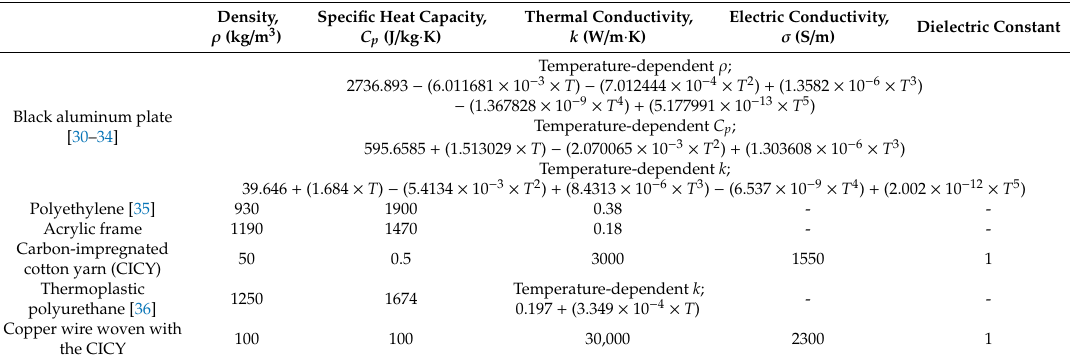
Table 1. Electrical and thermal properties used for the finite element